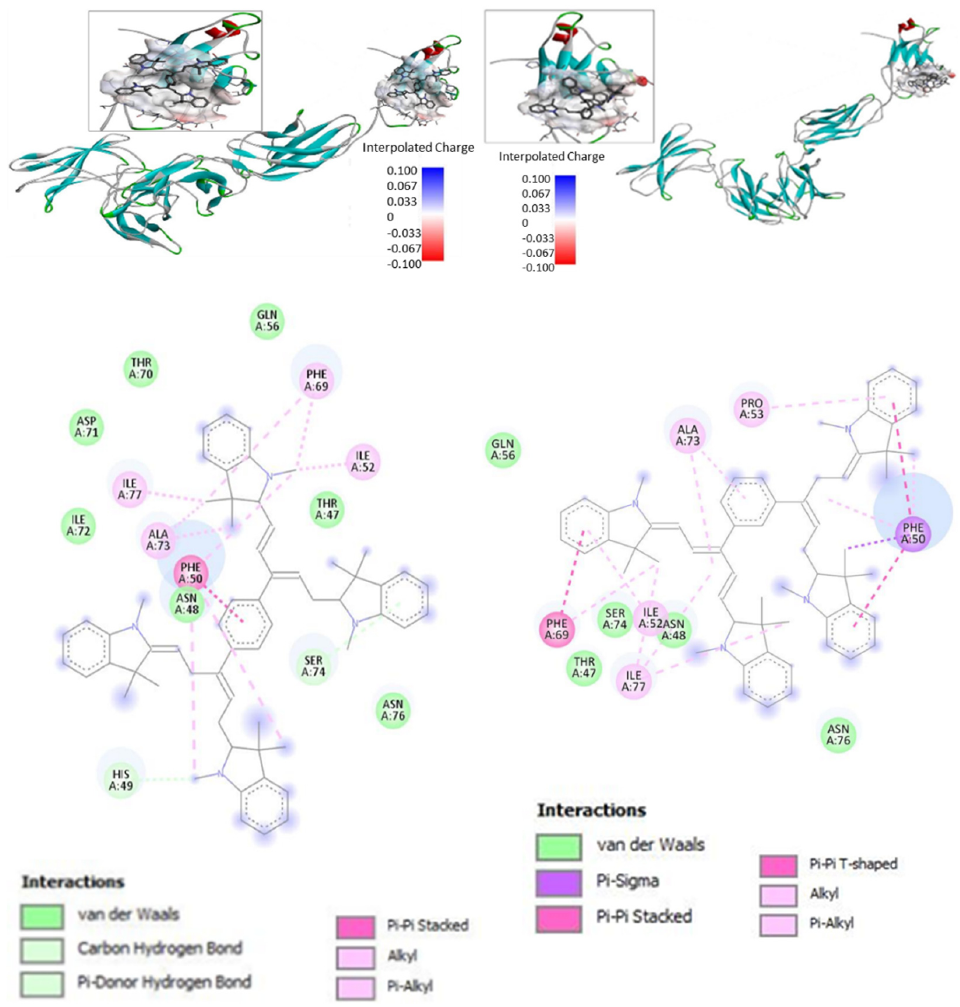
Figure 3. Docking of Bis-PMSs 5 and 6 to the IL-6 receptor (IL-6R) containing α and β subunits. Upper panels show a 3D model of IL-6R; the binding site (cavity) is localized in IL-6R β . Electron density in the binding site is shown as a color scale from blue ( low ) to red ( high ). Lower panels show the interaction of Bis-PMSs 5 and 6 with the amino acid residues of a homology model of IL-6R. Bis ‐ PMS 5 and 6 docked to the IL ‐ 6R, − 9.5 and, − 8.1 kcal/mol, respectively.